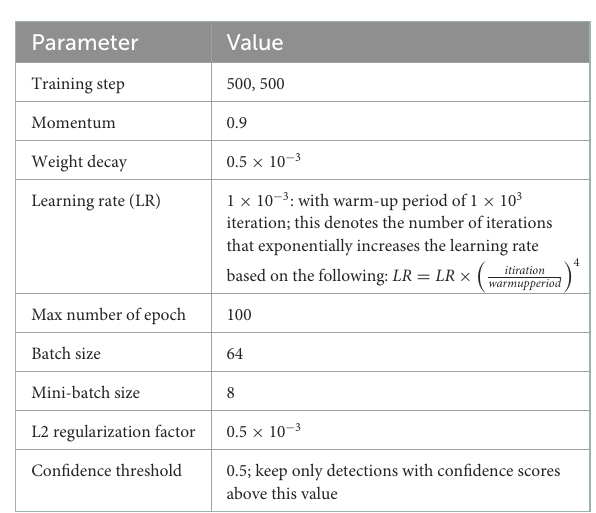
TABLE 2 Parameter selection used to train and evaluate the detection method; this includes the anchor